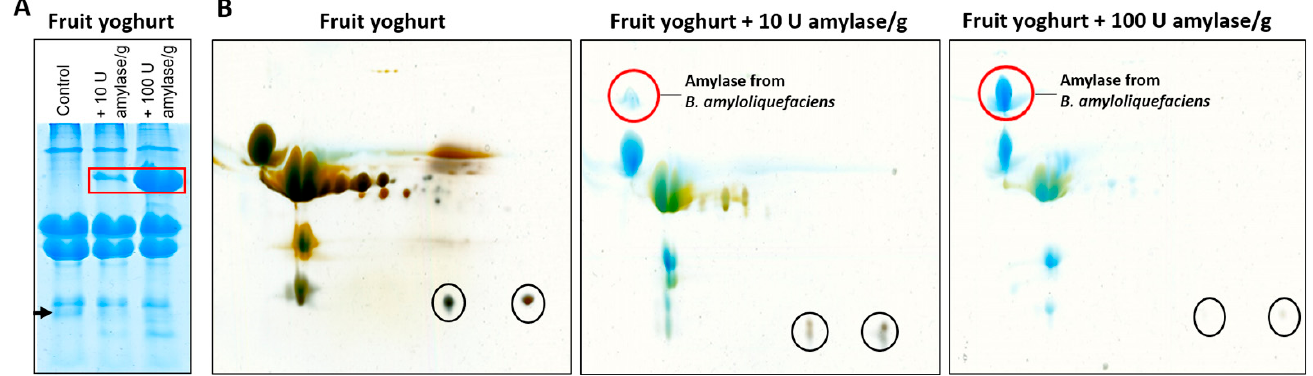
Figure 1. Fruit yoghurt spiked with amylase. ( A ) 1D SDS gel, colloidal Coomassie staining, and ( B ) 2D SDS gels of control fruit yoghurt and fruit yoghurt spiked with different amounts of amylase from B. amyloliquefaciens (colloidal Coomassie staining followed by silver staining). The red markers indicate the amylase bands or stains. The arrow and black circles indicate proteins with a molecular weight of approximately 18 kDa that were digested by amylase, as they weakened or disappeared with increasing amylase concentration.